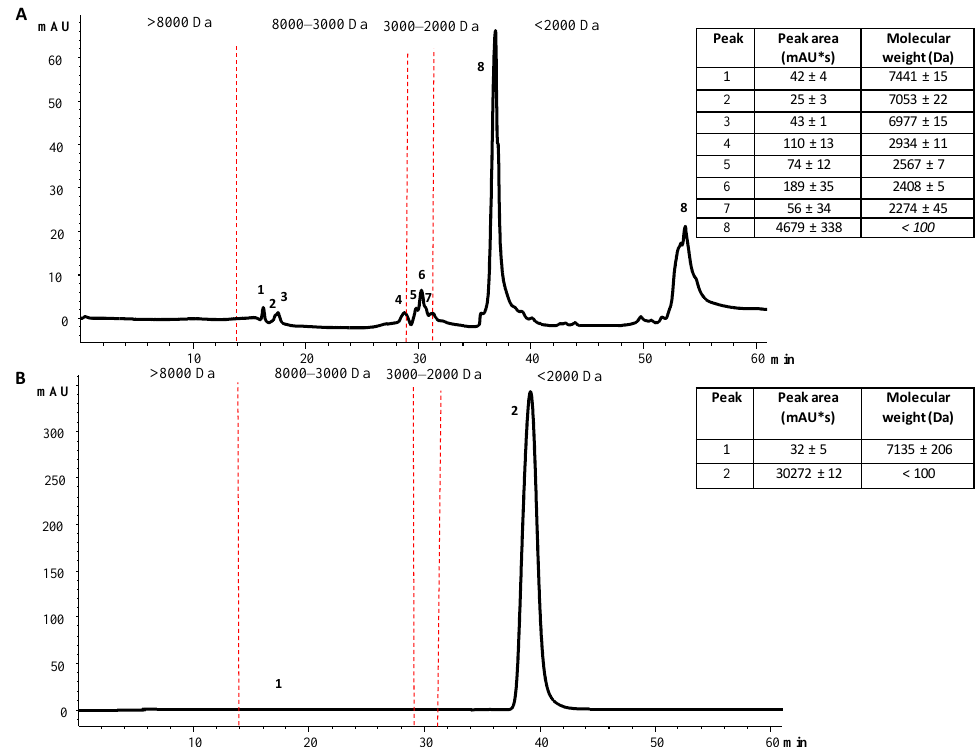
Figure 3. HPLC-SEC chromatogram profiles of the NEP extracts obtained under the optimal extraction conditions (60% ultrasound amplitude, 18.8% water percentage, and 15 min extraction time) by UAE with ChCl:LA (1:2) as the extraction solvent ( A ) and EPP extracts collected after conventional extraction methods ( B ) from mangosteen peel.